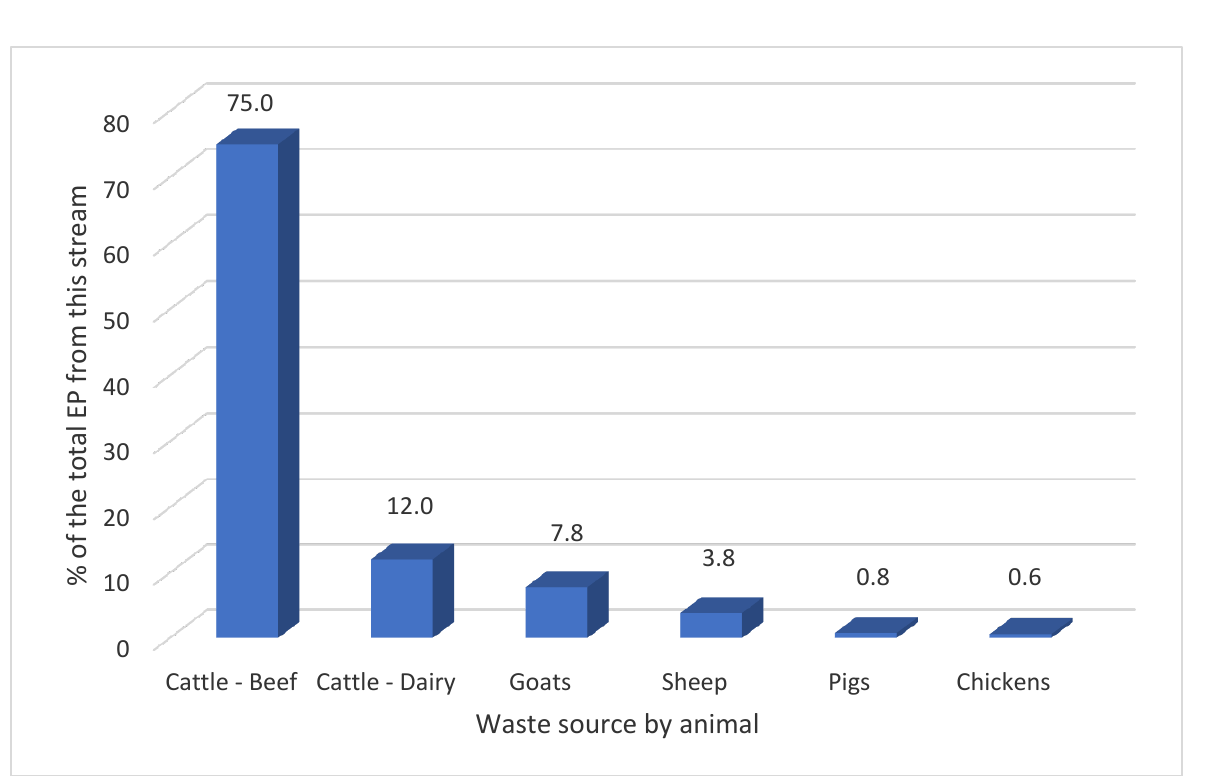
Figure 3. The total energy potential (%) available per animal. Table 9. The energy potential (EP) available from the livestock residues in Tanzania.